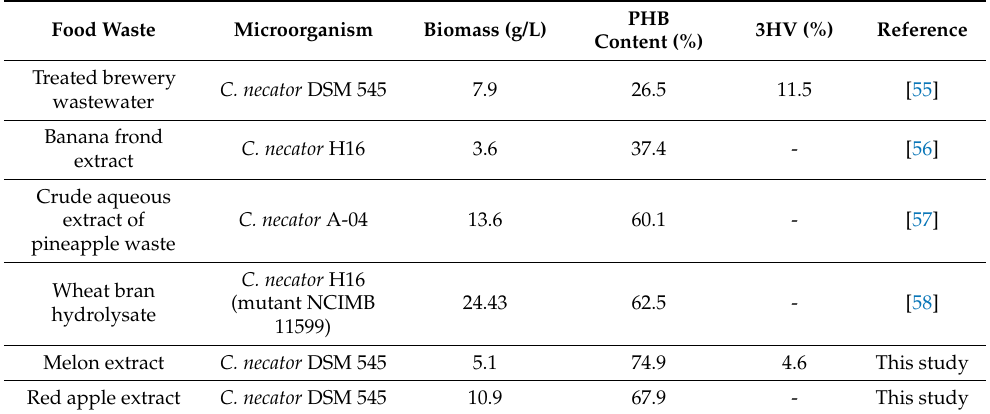
Table 4. Different food waste streams employed to produce 3HB and 3HV from various strains of C. necator under a batch fermentation strategy in